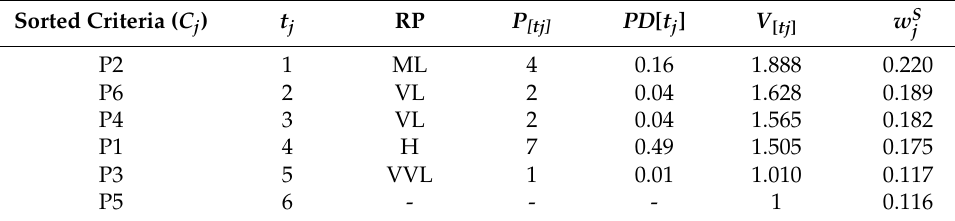
Table 7. Calculations of the subjective weights of bank productivity criteria.